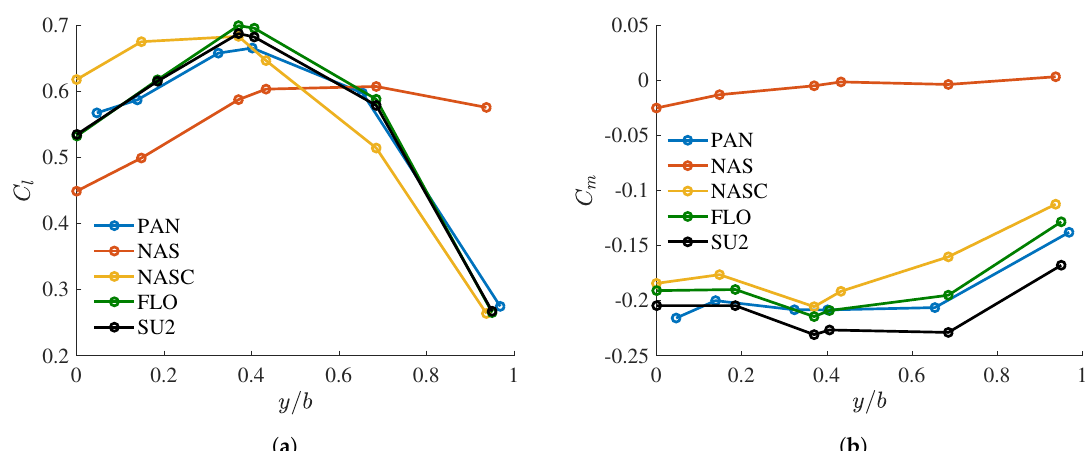
Figure 7. Sectional aerodynamic coefficients distribution along the span of the deformed Embraer wing at Mach 0.78 and lift coefficient 0.60, obtained from different levels of fidelity: ( a ) sectional lift coefficient; and ( b ) sectional moment coefficient.